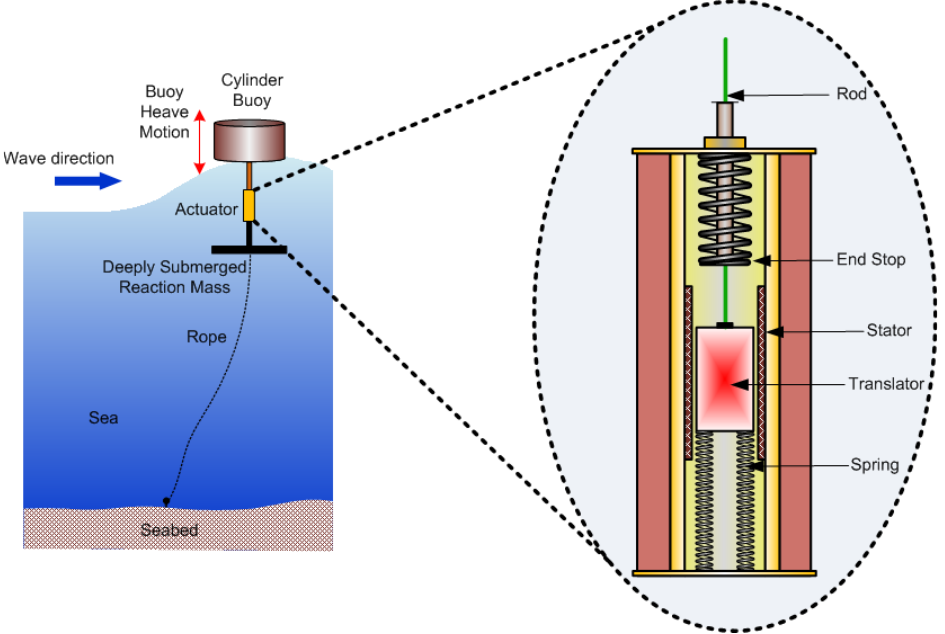
Figure 10. Cylindrical buoy actuator for wave